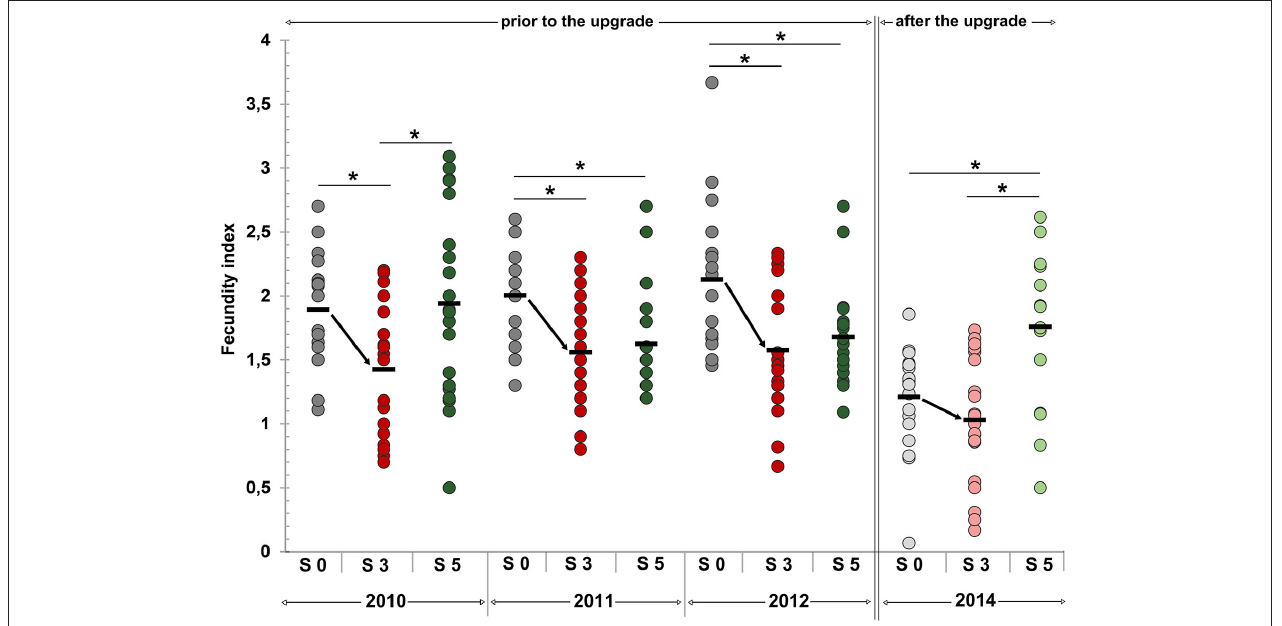
FIGURE 4 | Fecundity index of female gammarids in autumn prior to (2010–2012, dark colors) and after (2014, light colors) the wastewater treatment plant (WWTP) upgrade. Arithmetic mean is graphed as black bar. Sampling sites at the Schussen river in gray colors: S 0 upstream of the WWTP, and in red colors: S 3 downstream of the WWTP. Sampling site S 5 at the Argen river in green colors. Sampling sizes: At each sampling site per year n = 20 breeding females. Statistically analyzed via Welch’s t -test followed by sequential Bonferroni-Holm correction. Significant differences marked with asterisks: 2010S 0–S 3 p = 0.0034, S 3–S 5 p = 0.0149; 2011S 0–S 3 p = 0.0027, S 0–S 5 p = 0.0067; 2012S 0–S 3 p = 0.0025, S 0–S 5 p = 0.0066; 2014S 0–S 5 p = 0.0023, S 3–S 5 p = 0.0022. Furthermore, fecundity indices at S 0 in 2010, 2011, and 2012 were significantly higher compared to S 0 in 2014 ( p = 0.0125, p = 0.0125, p = 0.0120) (not marked in the graph). Same was true for fecundity indices at S 3 in 2010, 2011, and 2012 compared to S 3 in 2014 ( p = 0.0207, p = 0.0012, p = 0.0014) (not marked in the graph).